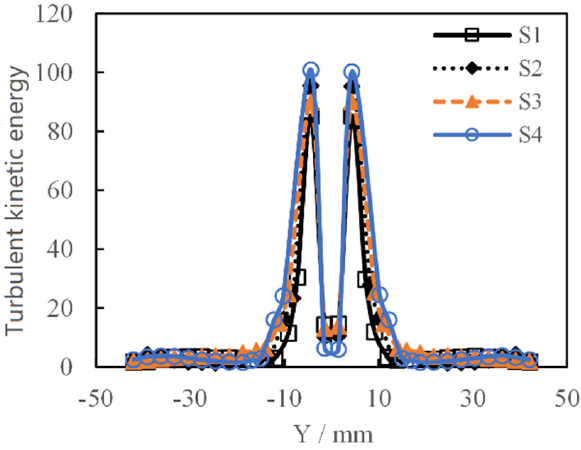
Figure 11. Radial profiles of turbulent kinetic energy at d = 2 mm under Schemes S1–S4.